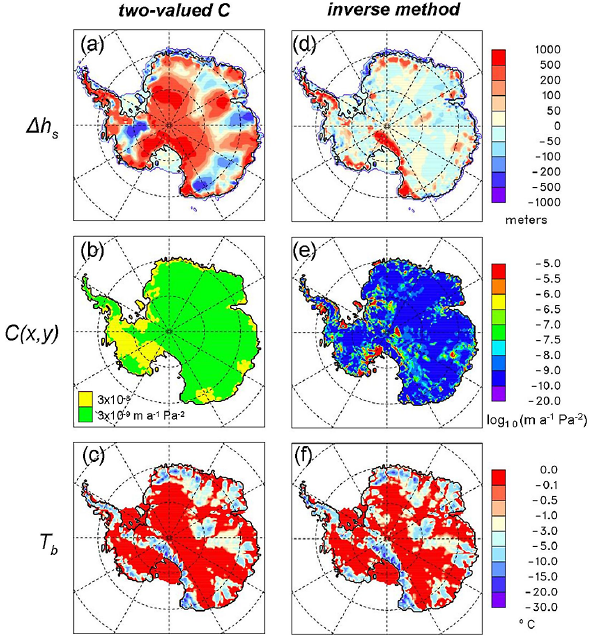
Fig. 1. Non-inverse (left) vs. basic inverse (right) results. Top row: model minus observed surface ice elevation, meters. Middle row: basal sliding coefficients C(x,y) , log 10 (ma − 1 Pa − 2 ) . Bottom row: homologous basal temperatures T b (relative to pressure melt point), ◦ C. Left column (a–c) : using prescribed two-value C(x,y) according to whether rebounded ice-free bed elevations are above or below sea level. Right column (d–f) : using basic inverse